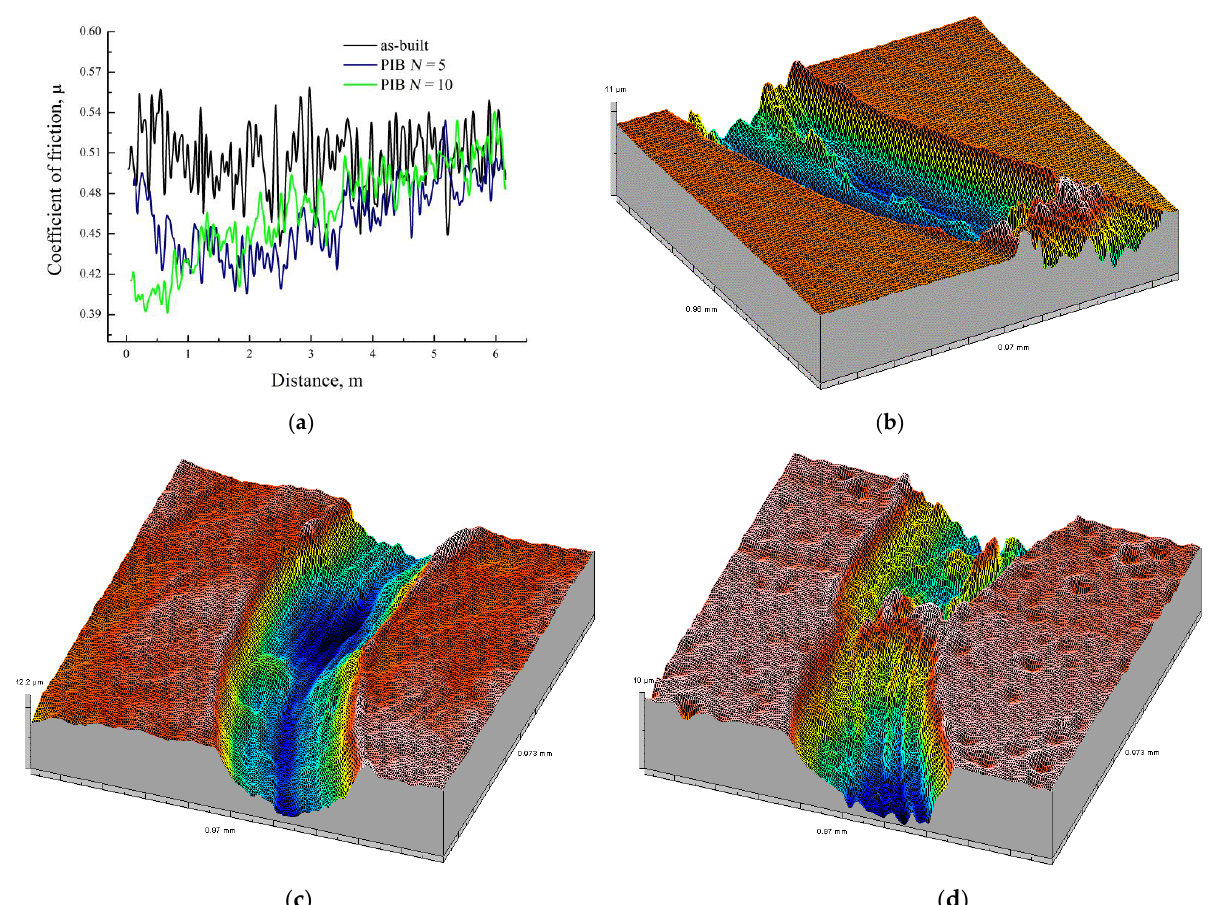
Figure 6. X-ray diffraction (XRD) patterns of the initial (as-built) sample and samples after PIB exposure.